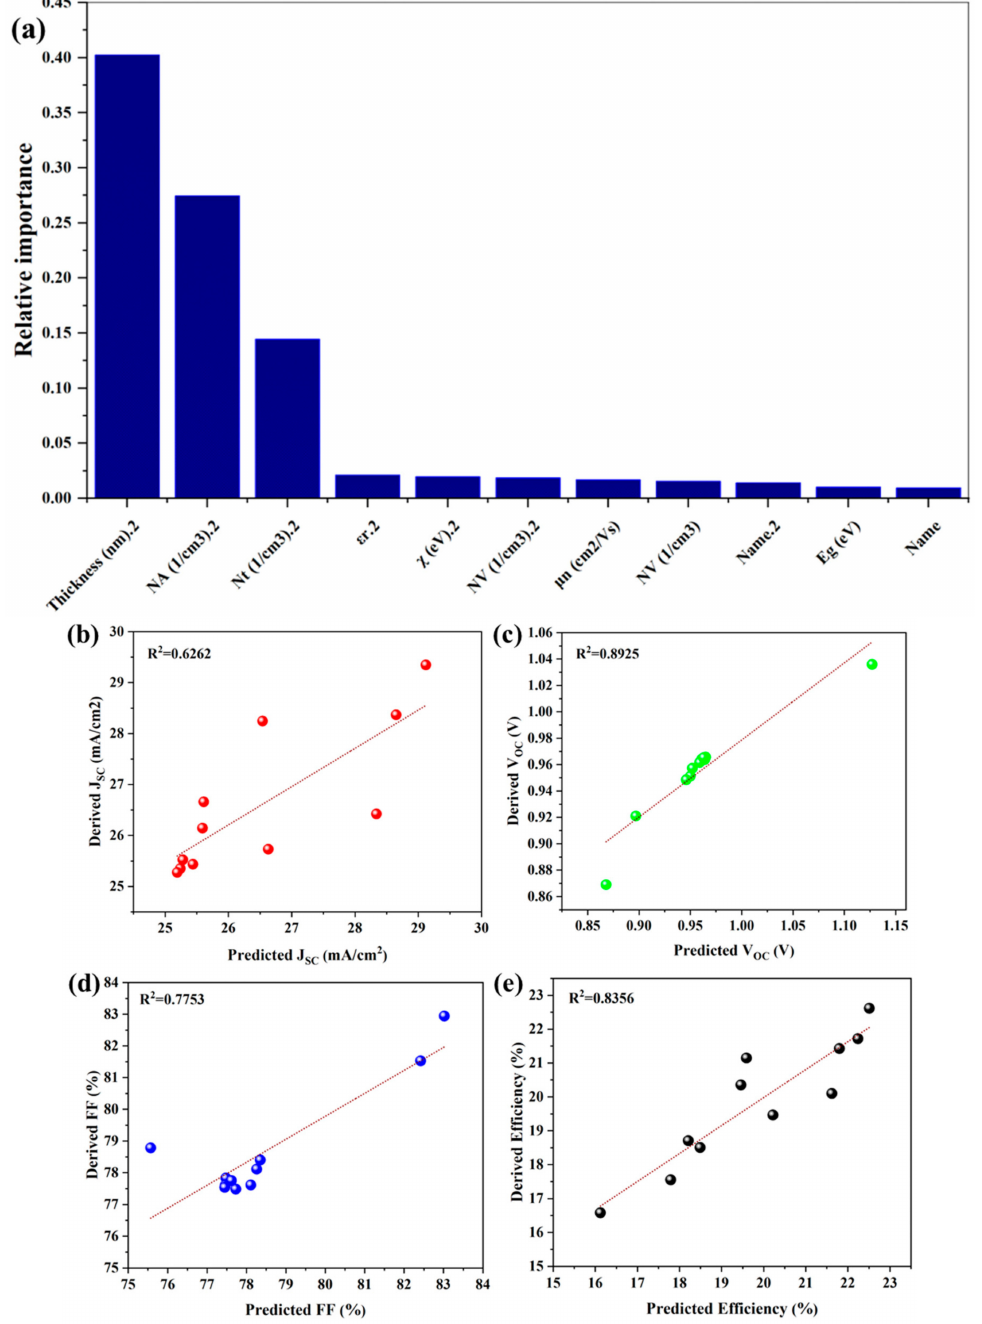
Figure 9. ( a ) Various features with the highest importance in the ML model. Derived and predicted values of ( b ) J SC , ( c ) V OC ( d ) FF ( e )